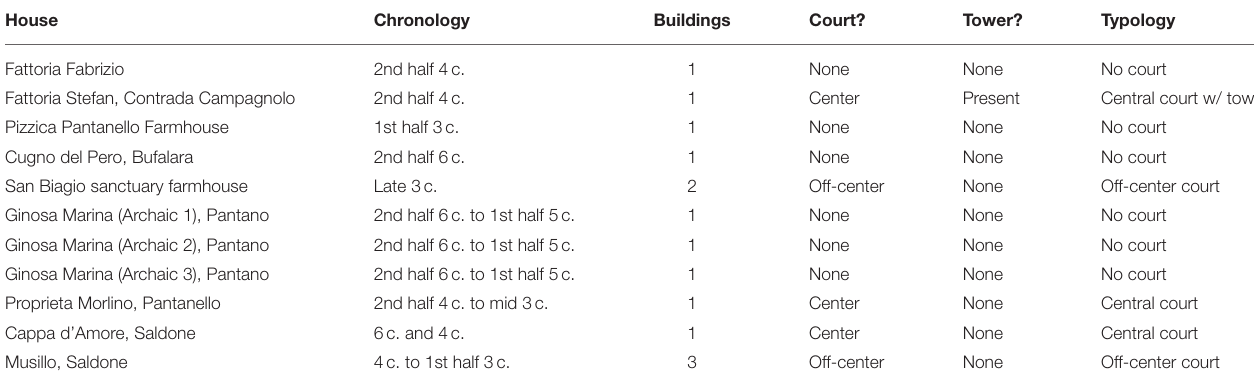
TABLE 1 | Rural houses at